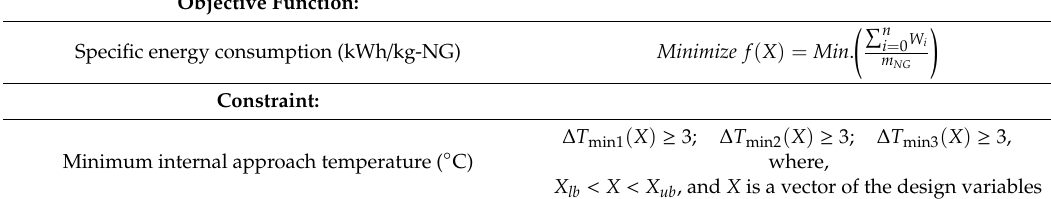
Table 2. Objective function, constraint and decision variables with their